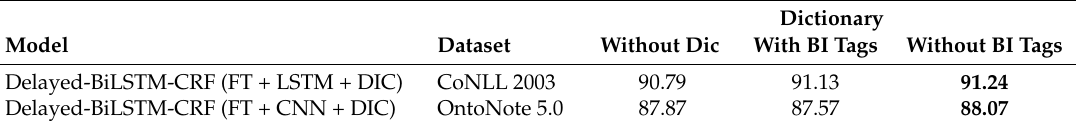
Table 8. The comparison of our models with and without dictionary